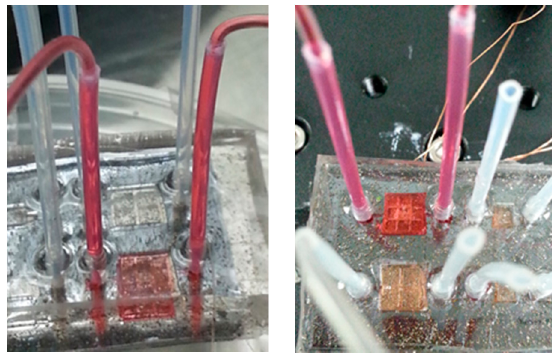
Figure 8. The photographs of the EM micropump under the leaking test.